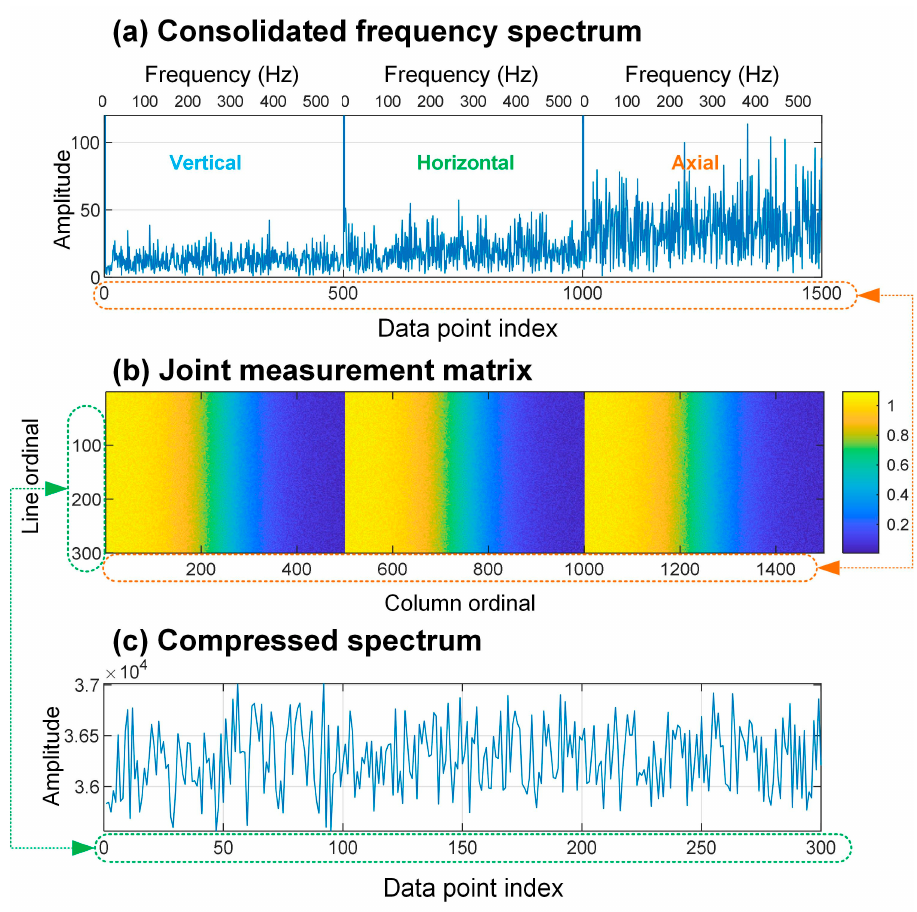
Figure 24. RPD: compression of frequency spectra.